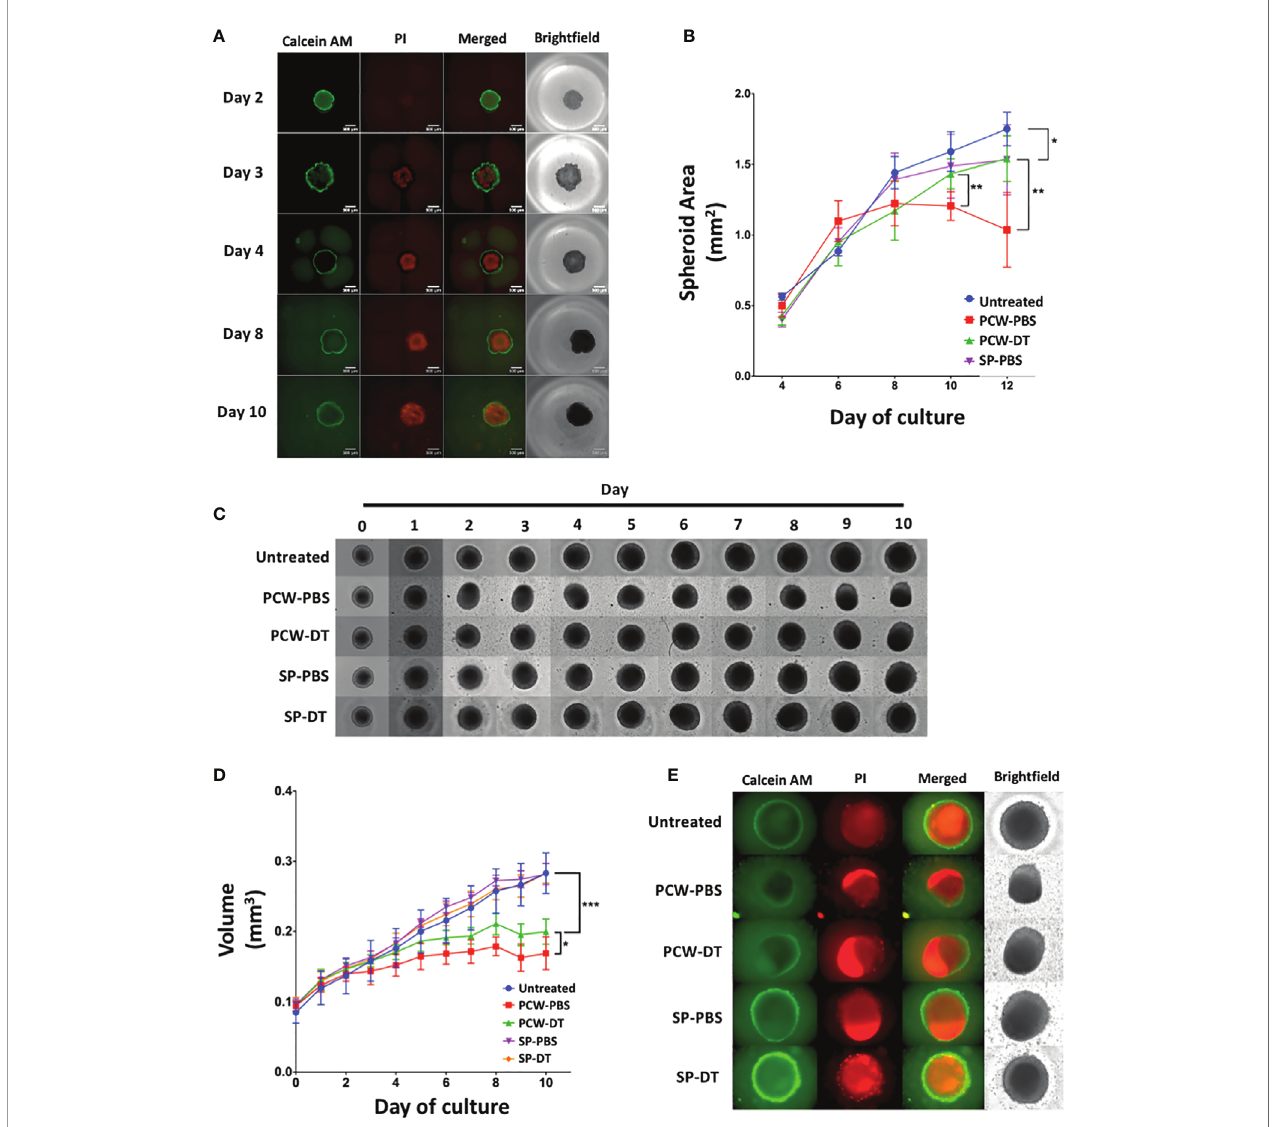
FIGURE 6 | L2pB1 cells inhibit tumor spheroid growth in vitro . (A) Calcein AM (CAM) and Propidium Iodide (PI) staining of B16F10 tumor spheroids (n=8). (B) Time course of spheroid size after treatment with various cell types (*P < 0.05; **P < 0.01). (C) Representative MC38 spheroids from each treatment group (n=8) over a 10-day co-culture period: untreated, PCW-PBS, PCW-DT, SP-PBS or SP-DT. (D) Time course of MC38 spheroid growth under different treatments. (*P < 0.05 (PCW-PBS vs. PCW-DT; ***P < 0.0001 [control vs. PCW-PBS)]. (E) Representative IF images on co-cultured MC38 spheroids at day 10. Data are representative of at least three independent